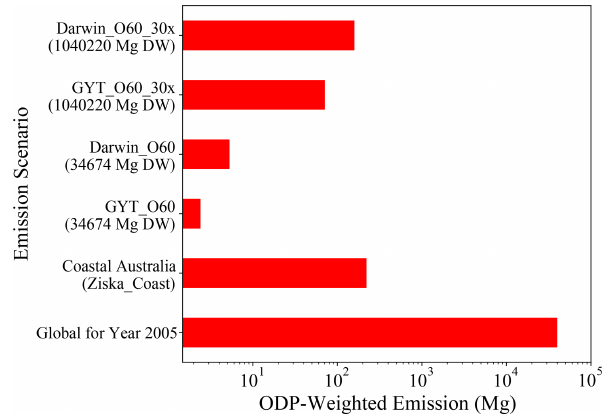
Figure 8. The ODP-weighted emissions of CHBr 3 for global scenarios (GTY_O60_30x and Darwin_O60_30x), Australian sce- narios (GTY_O60 and Darwin_O60), coastal Australian emission (Ziska_Coast), and global ODP-weighted emission for 2005 taken from Tegtmeier et al. (2015) as a reference; note that the x axis is